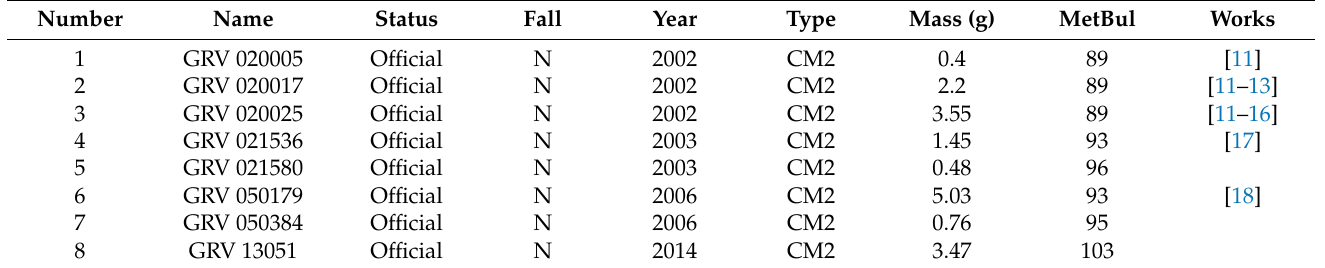
Table 1. General information of CM chondrites found in Grove Mountains, Antarctica.